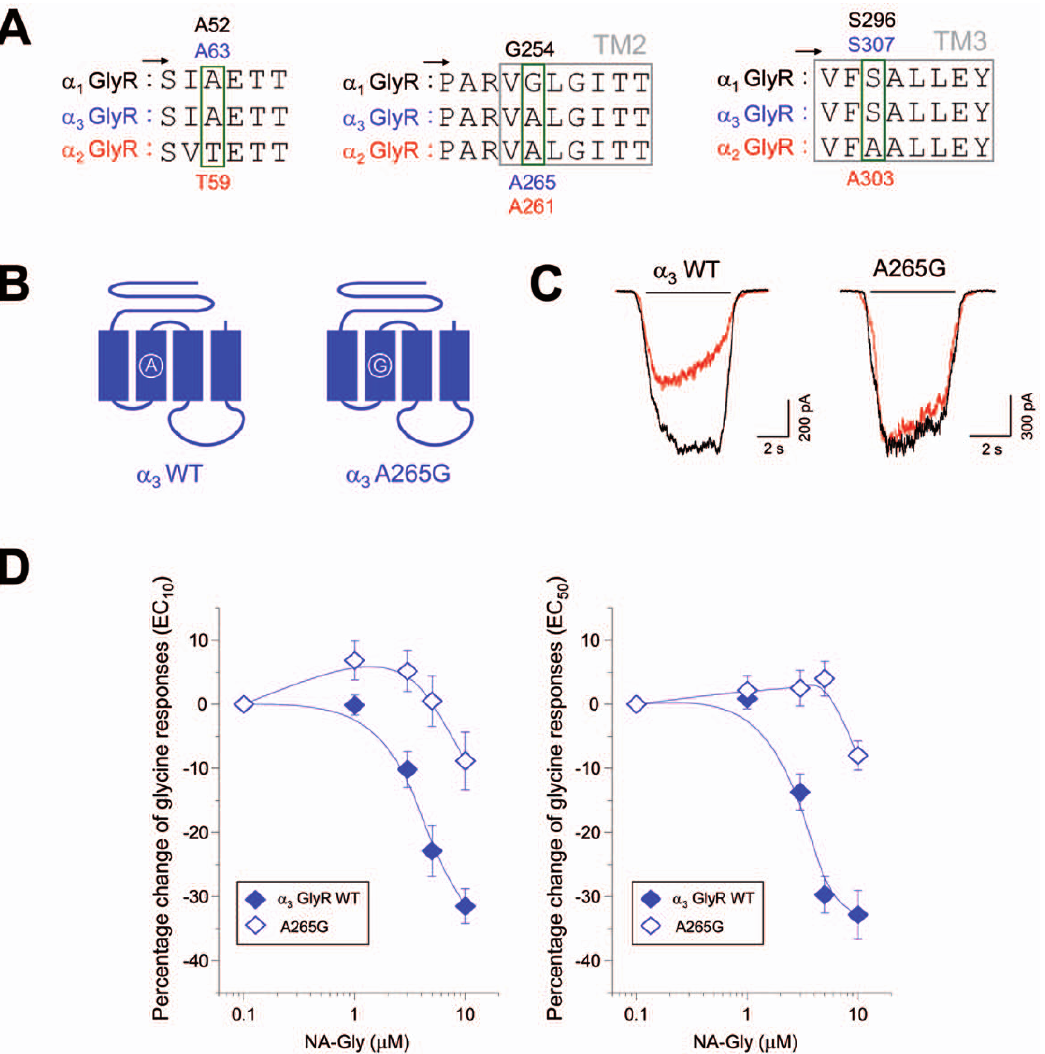
Figure 6. The negative allosteric effects of NA-Gly on a 3 GlyRs were attenuated but not reverted by altering the TM2 domain composition. ( A ) Primary sequence alignment of a 1 , a 2 and a 3 GlyR subunits in selected extracellular loop 2, TM2 and TM3 segments ( B ) Schematic depiction of wild type and point mutated a 3 GlyRs. ( C ) Examples of current traces through wild-type and point-mutated a 3 GlyRs in absence (black) or presence of NA-Gly (10 m M, red) ( D ) Concentration-response curves for NA-Gly in wild-type and TM2-mutated a 3 GlyRs using two different glycine concentrations. Note that this specific mutation A265G in a 3 GlyRs significantly attenuated the NA-Gly-induced inhibition, but did not convert the inhibition into